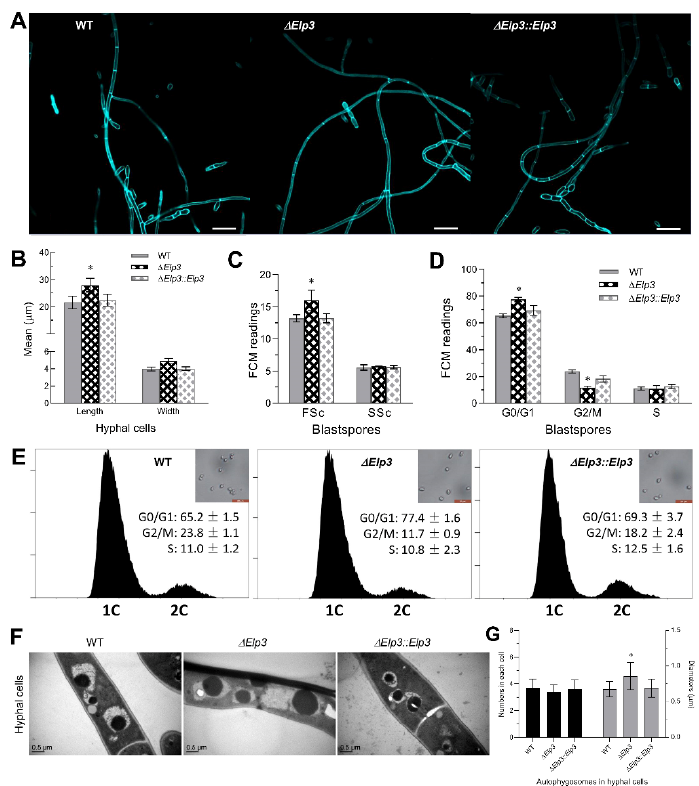
Figure 3. Impact of loss of Elp3 on cell cycle, hyphal septation, and autophagosome formation in B. bassiana . ( A ) Representative microscopic of hyphal cells (3 d SDB cultures) stained with calcofluor white. Scale bars = 20 μ m. ( B ) Quantification of mean hyphal cell length and width. ( C ) FACS anal- yses of blastospore (harvested from NLB cultures grown for 3 d) cell size (FSc) and cell density (SSc). ( D , E ) FACS analysis for blastospore cell cycle progression. ( F ) Representative TEM images of hyphal cells (3 d SDB cultures) treated with 10 μ g mL − 1 rapamycin for 12 h. Scale bars = 0.5 μ m. ( G ) Quan- tification of the average numbers and diameters of autophagosomes in each rapamycin-treated hy- phal cell. Asterisk indicates significant difference ( p < 0.05) from unmarked (Tukey’s HSD). Error bars: SD from three technical replicates.